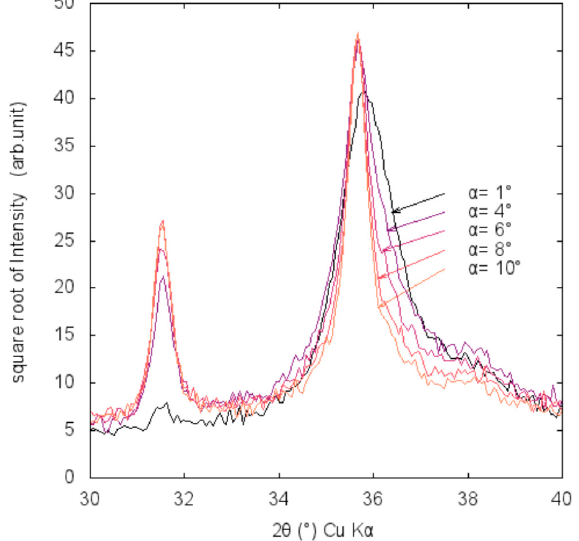
Figure 5. XRD scans of sample Al80CrN–50 with variation of the incident angle α = 1–10 ◦ .